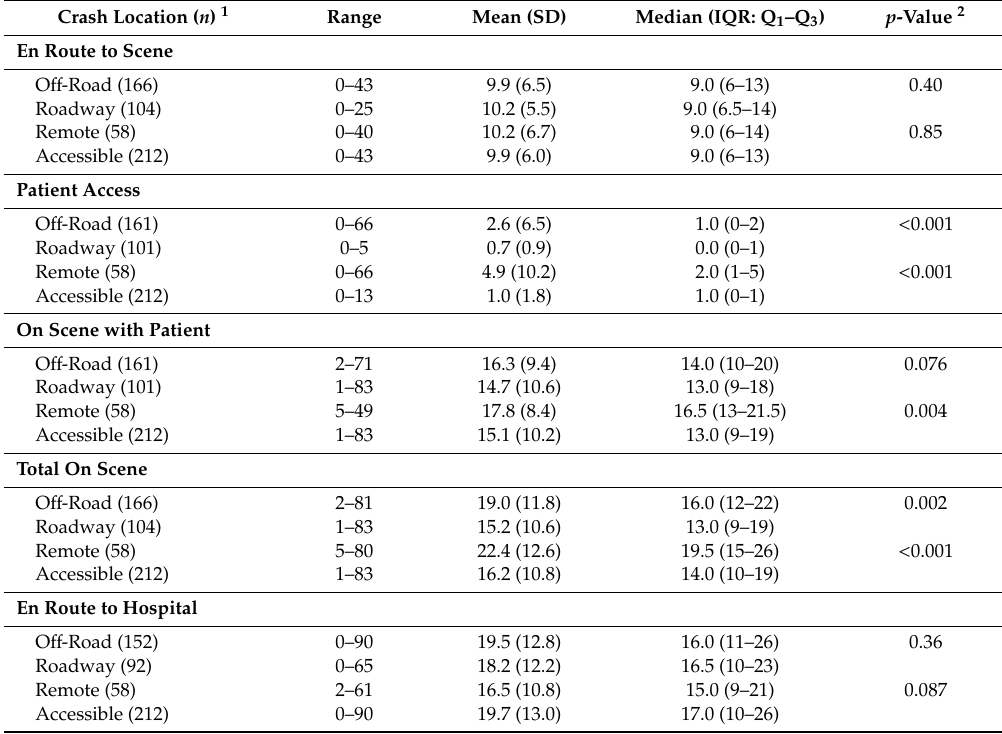
O ff -road (N = 166) versus roadway (N = 104) and remote (N = 58) versus accessible locations (N =